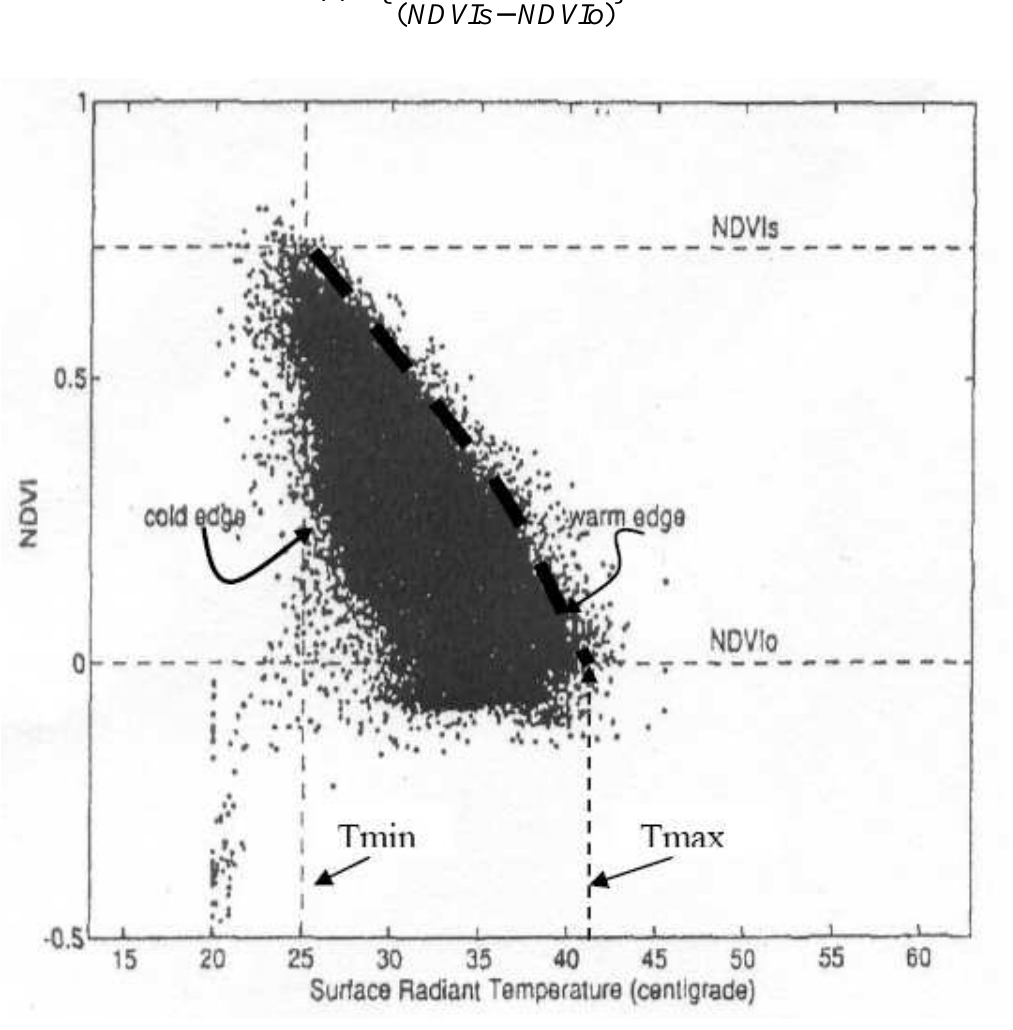
Figure 2. Scatter plot of NDVI versus surface radiant temperature for an NS001 image over Walnut Gulch, Arizona during summertime. Salient features of the triangle are: the maximum and minimum temperatures as vertical, dashed lines (Tmax and Tmin), the warm edge (heavy dashed line), the cold edge and the limits for dense vegetation (NDVIs) and bare soil